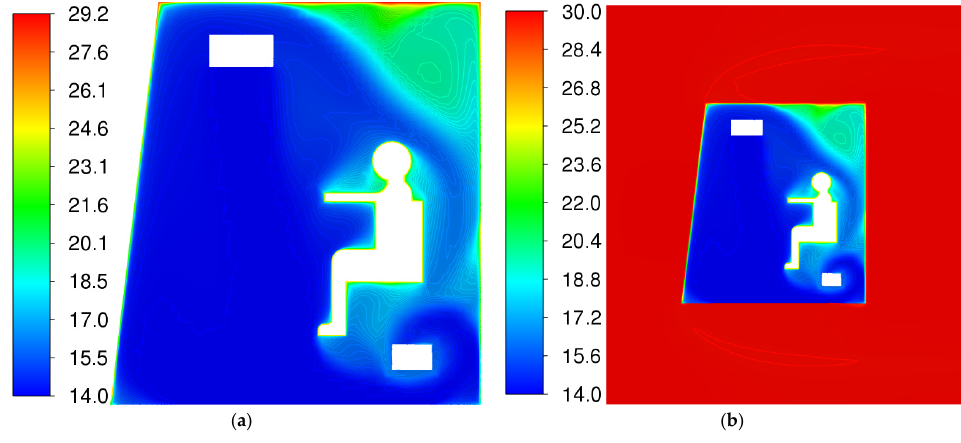
Figure 7. Temperature, °C: ( a ) in the cabin; ( b ) in all domains.